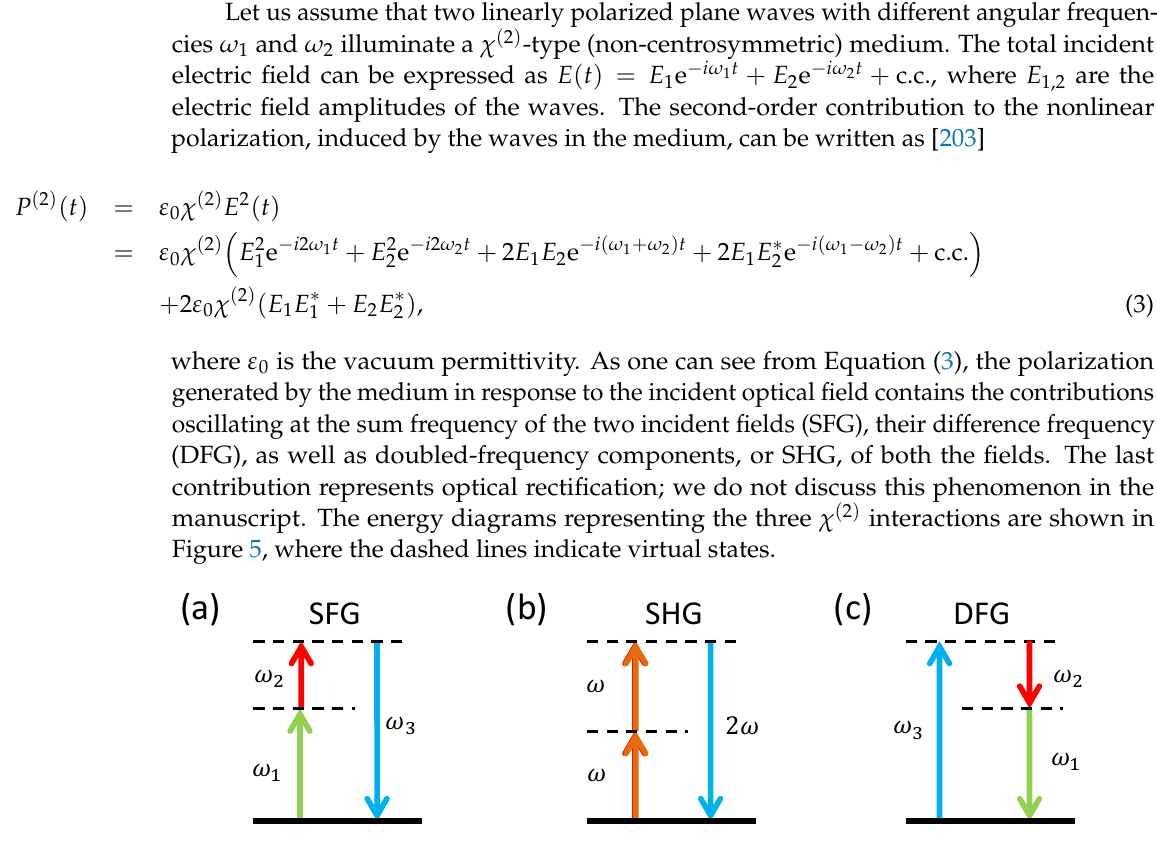
Figure 5. Energy-level diagrams associated with χ ( 2 ) -related phenomena: ( a ) sum-frequency genera- tion, ( b ) second-harmonic generation, and ( c ) difference-frequency